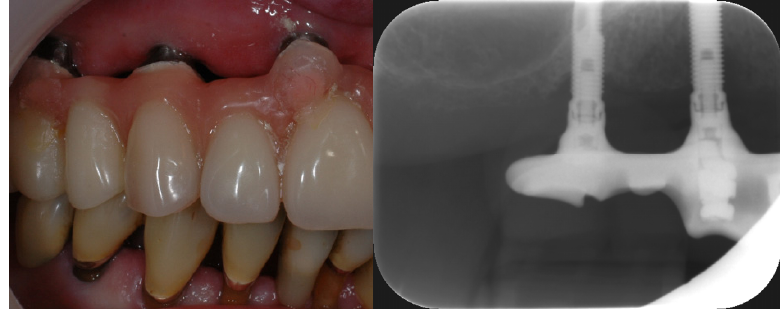
Figure 6. Implant in the upper jaw supporting a fixed denture. The rough area on the molar region implant is exposed due to previous periimplantitis (photo: Marit Øilo).